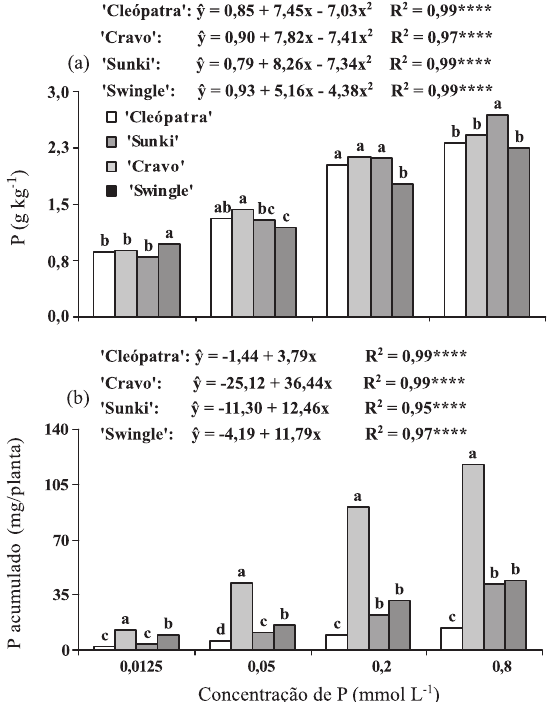
figura 2. teor de P nas folhas (a) e P acumulado (b) por quatro porta-enxertos cítricos submeti- dos a concentrações de P na solução